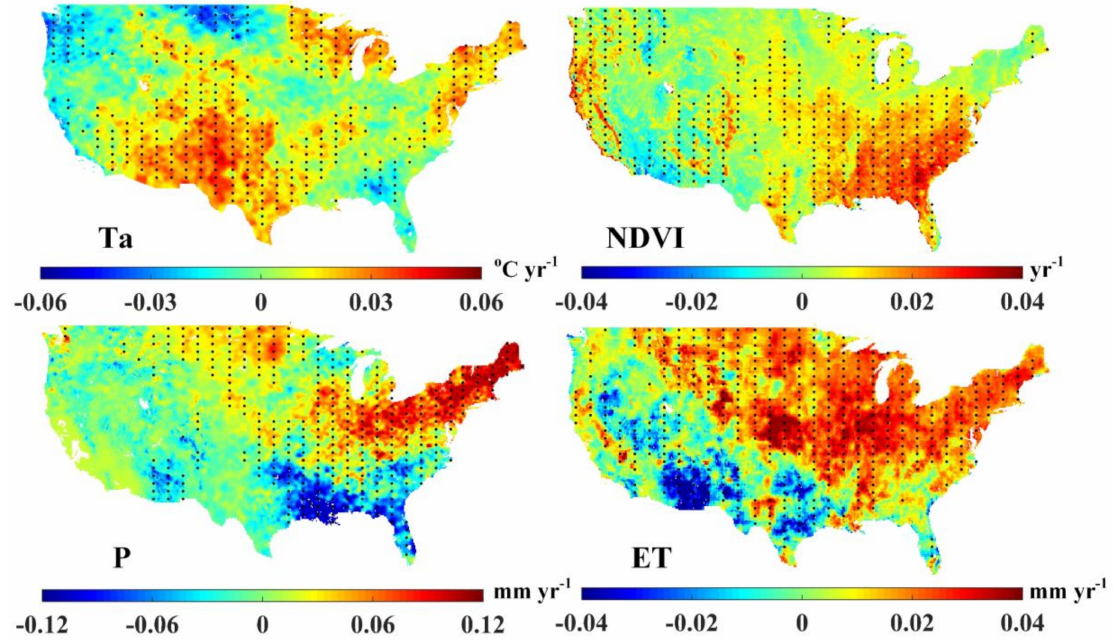
Figure 7. The spatial pattern of trends in air temperature (Ta), normalized di ff erential vegetation index (NDVI), precipitation ( P ), and evapotranspiration (ET) over the contiguous United States from 1982 to 2011. The black points represent 95% level of